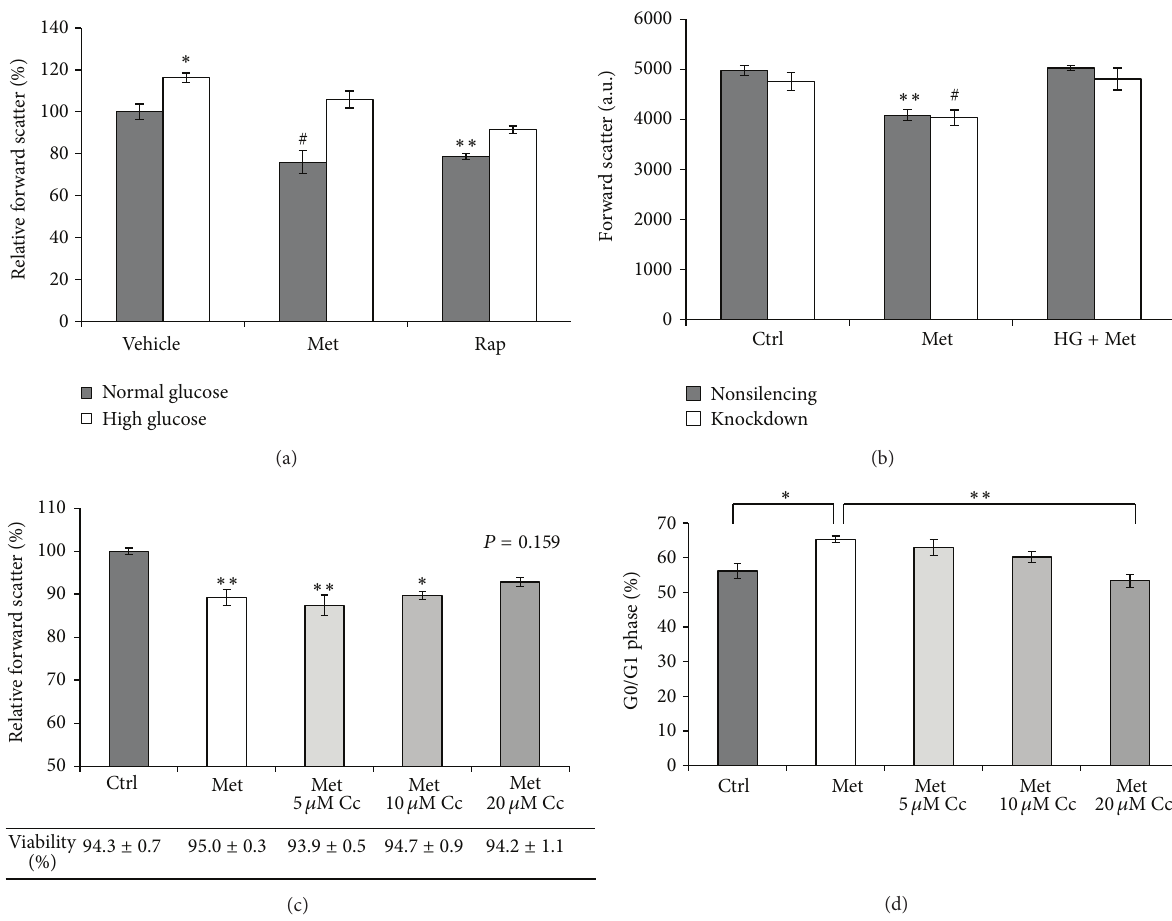
Figure 4: (a) High glucose reverses metformin-induced cell size decrease in HEK293 cells. The cells were cultured with 5.5 mM (Ctrl) or 30 mM D-glucose (HG) for 3 days. For the last 24 h, 8mM metformin or 100 nM rapamycin was added. Cell size was measured by flow cytometry. (b) AMPK 𝛼 2-deficiency has no effect on metformin-mediated cell size reduction. The cells were incubated in 5.5 or 25 mM (HG) D-glucose for 3 days. For the last 24 h, metformin 8 mM (Met) was added. (c) Compound C reverses metformin-induced cell size reduction. HEK293 cells were cultured with or without (Ctrl) 8mM Met. At the indicated concentrations, compound C (Cc) was added to the cells and cocultured with Met for 24h. The viability of the cells was determined by propidium iodide staining. Vehicle effects of compound C were controlled by keeping the concentration of DMSO at 0.2% in the conditions. (d) Dose-dependent reversal of metformin-induced cell cycle arrest by compound C. HEK293 cells were exposed to the experimental conditions described in Figure 4(c). The results are expressed as mean ± SEM of three independent experiments. ∗ 𝑃 < 0.05 ; ∗∗ 𝑃 < 0.01 ; # 𝑃 < 0.001